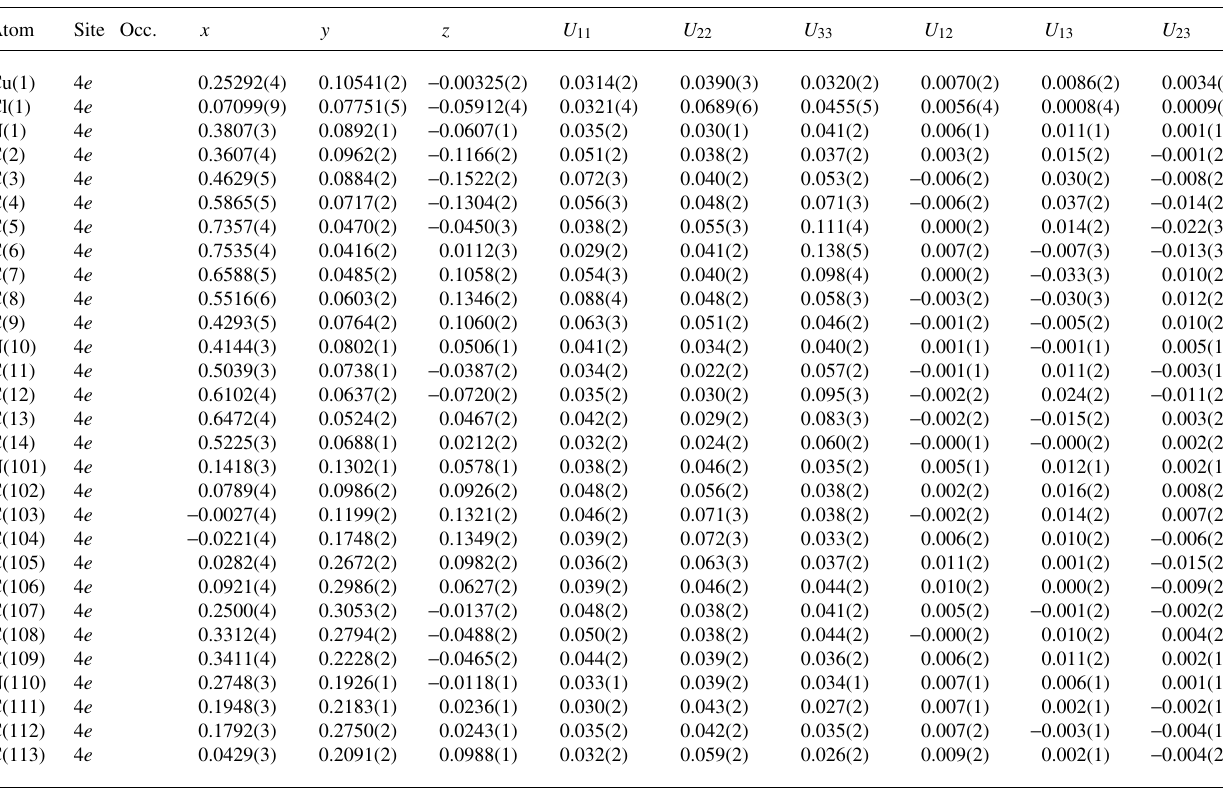
Table 3. Atomic coordinates and displacement parameters (in Å 2 ) .